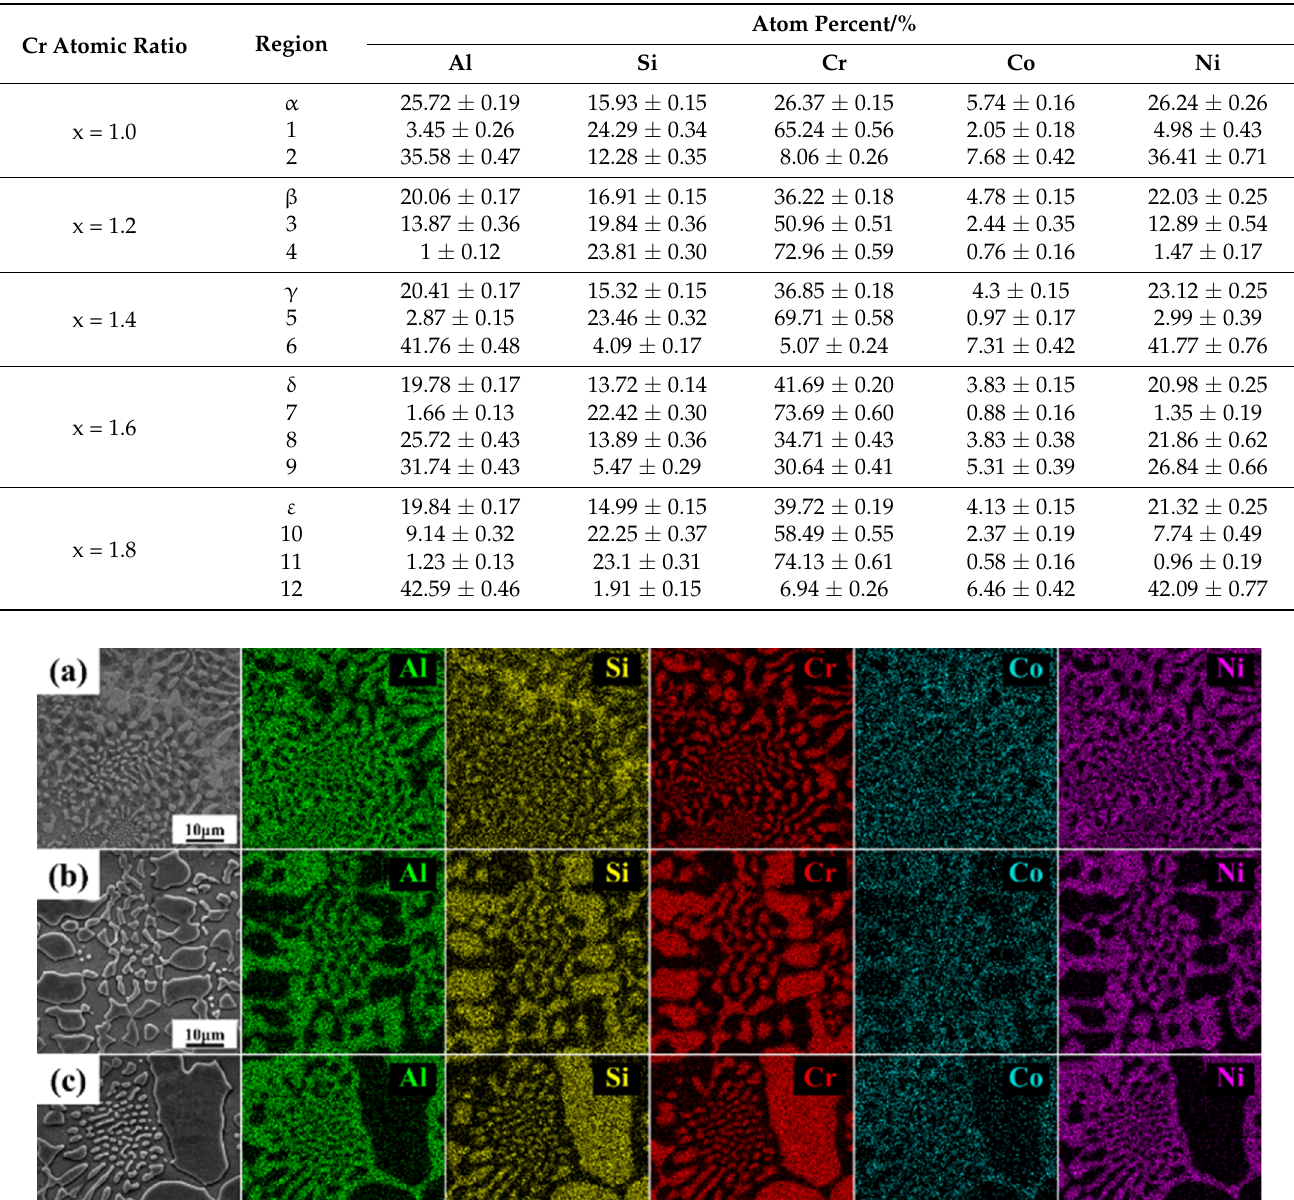
Figure 2. Microstructures of AlSi 0.5 Cr x Co 0.2 Ni high entropy alloys; ( a ) x = 1.0, ( b ) x = 1.2, ( c ) x = 1.4, ( d ) x = 1.6, and ( e ) x = 1.8. Table 2. EDS analysis data of enlarged images and marked points in Figure 2. Table 2. EDS analysis data of enlarged images and marked points in Figure 2.